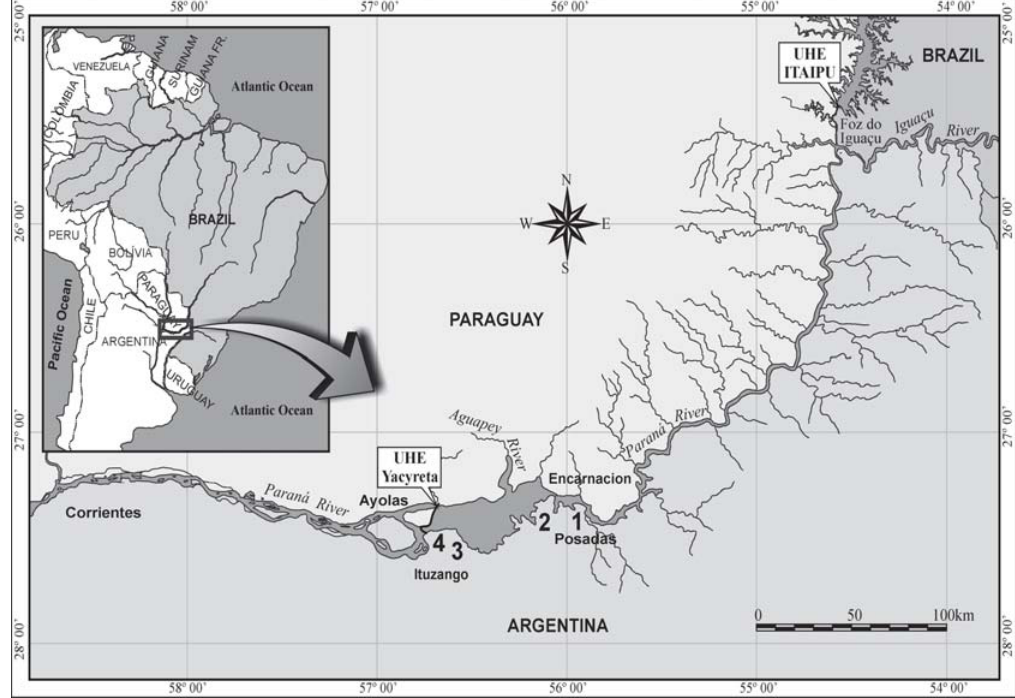
Fig. 1. Sampling area. 1- Yabebiry Stream; 2- Nemesio Parma; 3- Puerto Valle, 4- Puerto